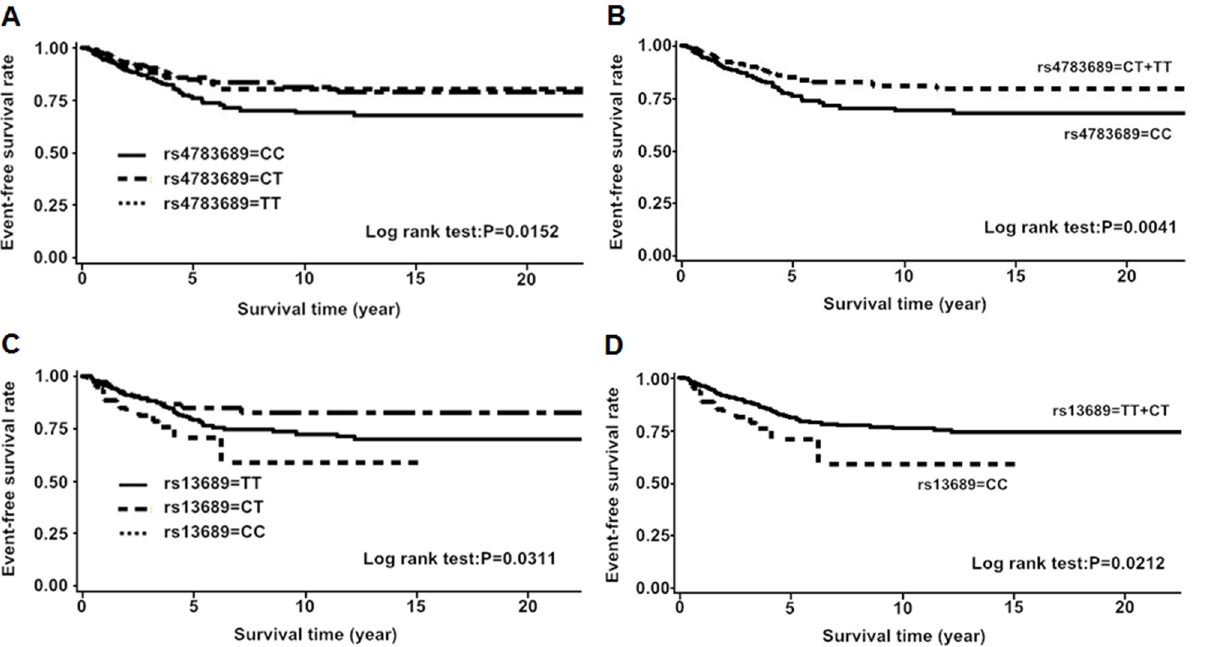
Fig 2. Kaplan-Meier estimates of event-free survival according to SNP rs4783689 and rs13689. A and B for rs4783689; C and D for